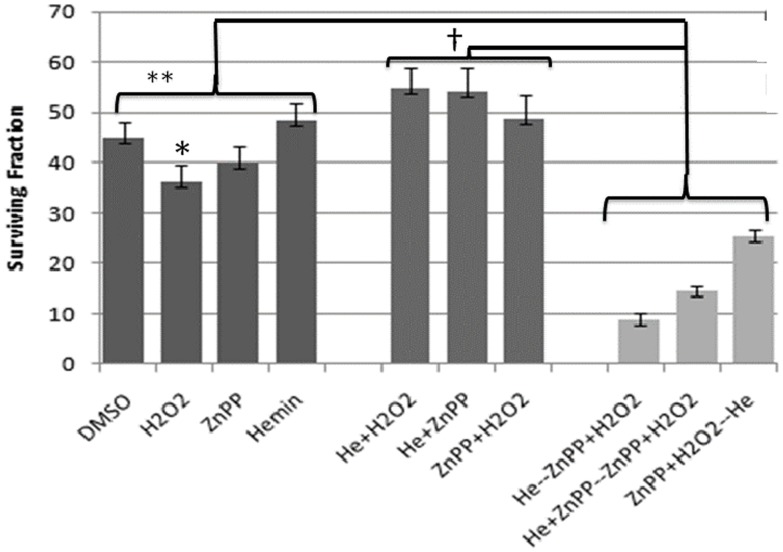
Tumoricidal effect of the combination of hemin, H2O2 and ZnPP in a clonogenic tumor survival model.Three agent regimens consisting of pre-treating 4T1 cells with i) hemin alone or combined with ZnPP for 2 hrs followed by the combination of ZnPP and H2O2 for 2 hrs or, ii) ZnPP for 2 hours followed by the combination of hemin and H2O2 for 2 hours induced significant tumor cell death compared to each agent individually (**p<0.0002) and any two of these agents used simultaneously (†p<0.0001). Clonogenic survival is shown as a mean of three independent experiments with standard error (SE) indicated. See Table S2 for protocol used in these studies.